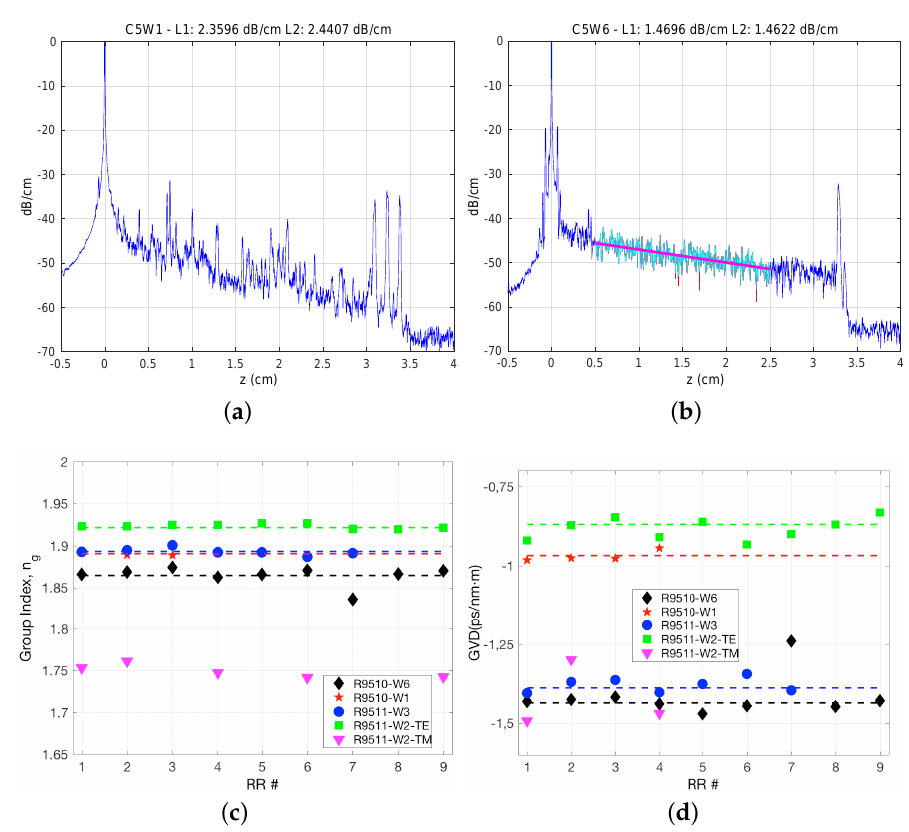
Figure 10. Impact on process steps on the linear propagation characteristics: OFDR measurement for spiral waveguides without ( a ) and with ( b ) oxidination of the Si 3 N 4 waveguide after etching; group index ( c ) and GVD ( d ) for the different processing steps